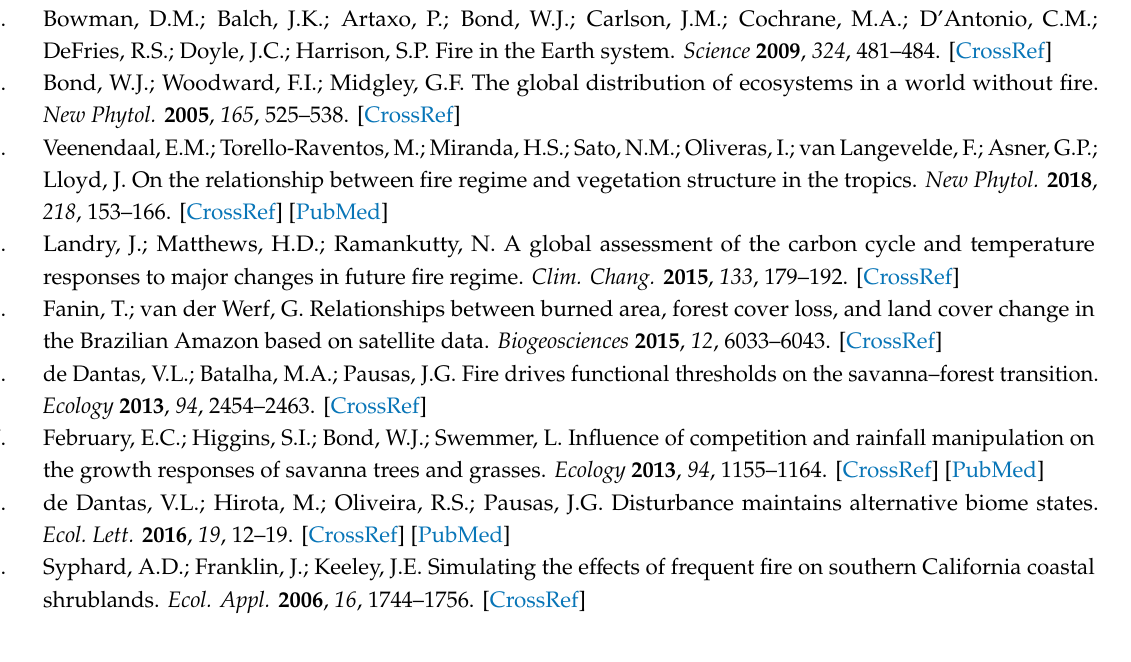
Figure S5: The standard deviations of the vegetation changes (a-d) and the e ff ects from fire (e-h) during 2001-2013; Table S1: The Climatic and soil condition in NHAF_Forest, SHAF_Forest and